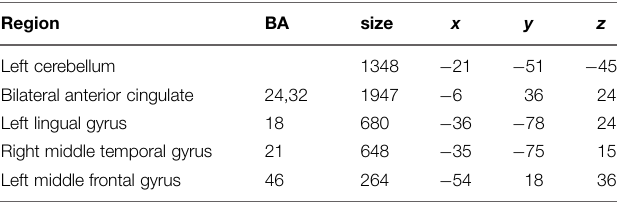
TABLE 2 | Brain regions with interaction effect between group and frequency.